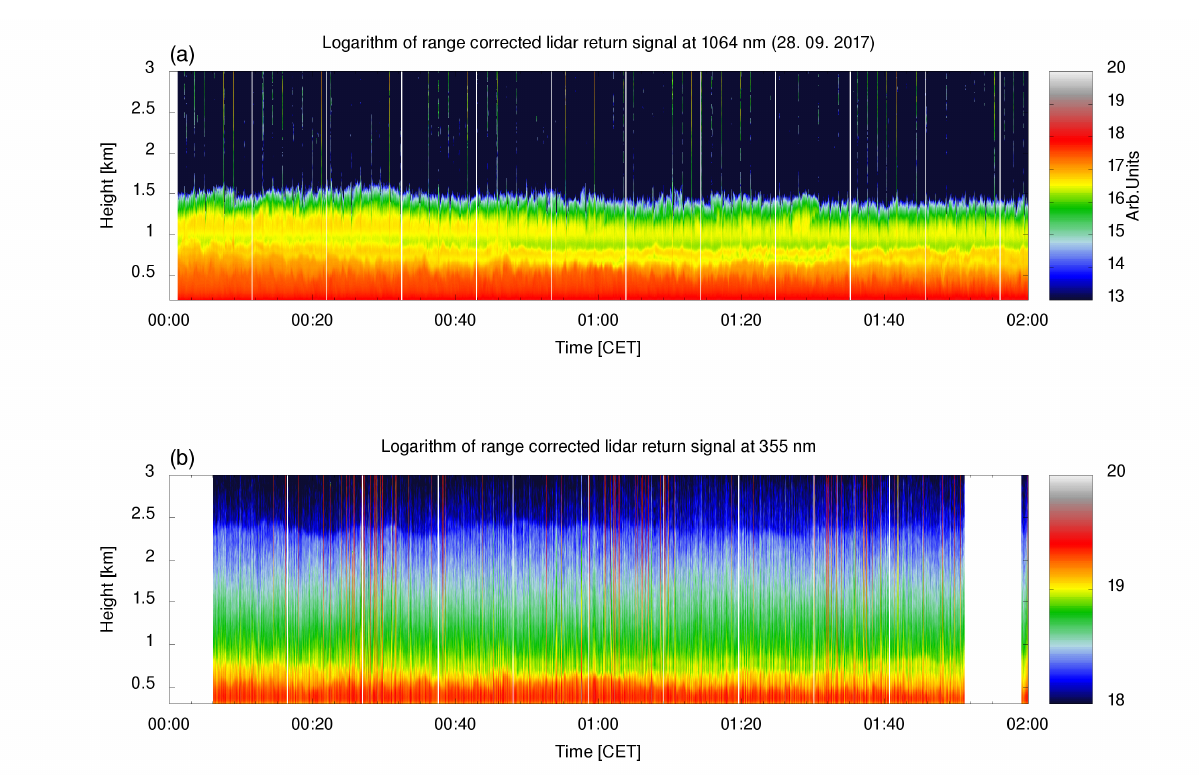
Figure 11. Temporal variation of the IR LiDAR return ( a ) and UV LiDAR ( b ) returns on 28 September 2017 between 00:00 and 02:00 CET shows a stable PBL with a height of about 800m, and a residual layer with a high fraction of coarse particles up to about 1.5km and with a low fraction of coarse particles up to about 2.5 km. The data were resampled to a 18.75-m range resolution and plotted within the complete overlap range, starting above 300m. The heights are relative to Ajdovšˇcina.